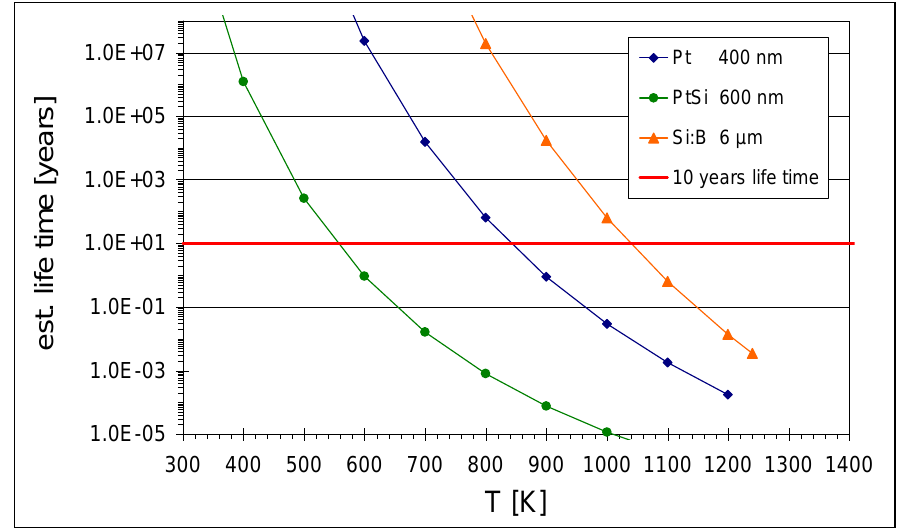
Figure 8. Lifetime estimation for EM1 emitters operated with DC voltage in ambient air. This estimation may be to optimistic as membrane degradation and thermal stress due to the emitter operation (switch on and off) is not taken into account. Nevertheless, 10 years of operation at 1000 K are considered realistic in the case of Si:B